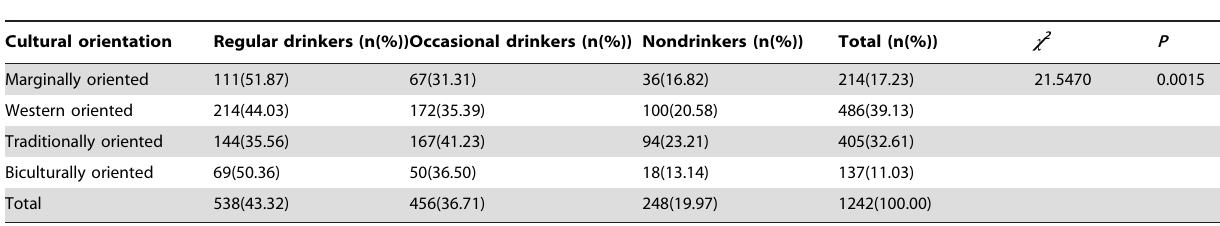
Table 3. Drinking behaviors by cultural orientation